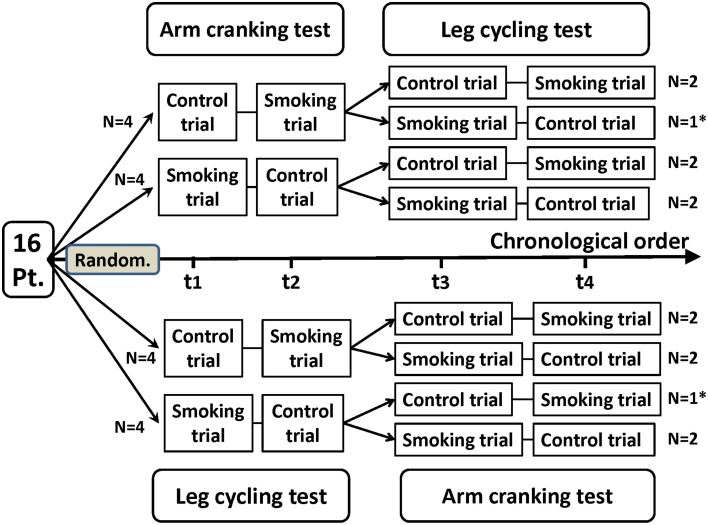
Flowchart of a randomized crossover trial of arm cranking and leg cycling tests in 14 healthy participants. Pt, participants; Random, randomization; t1, trial 1; t2, trial 2; t3, trial 3; t4, trial 4. *Two participants discontinued the intervention because of personal reasons unrelated to the trial. These participants were not included in the analysis.